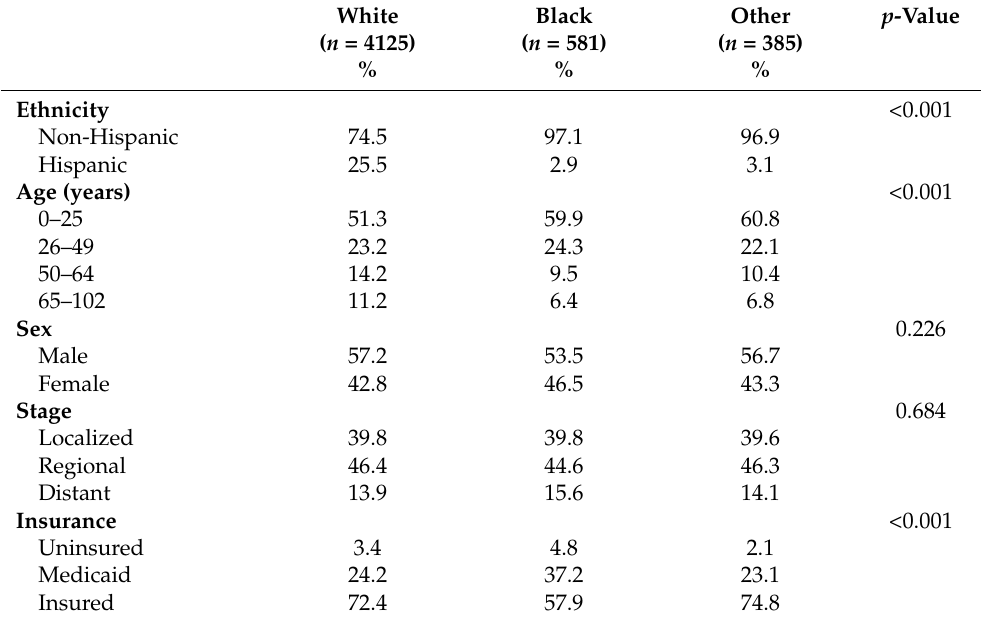
Table 1. Characteristics of study participants with primary bone neoplasms who received surgical treatment according to race from 1998 to 2016. White Black Other p -Value ( n = 4125) ( n =